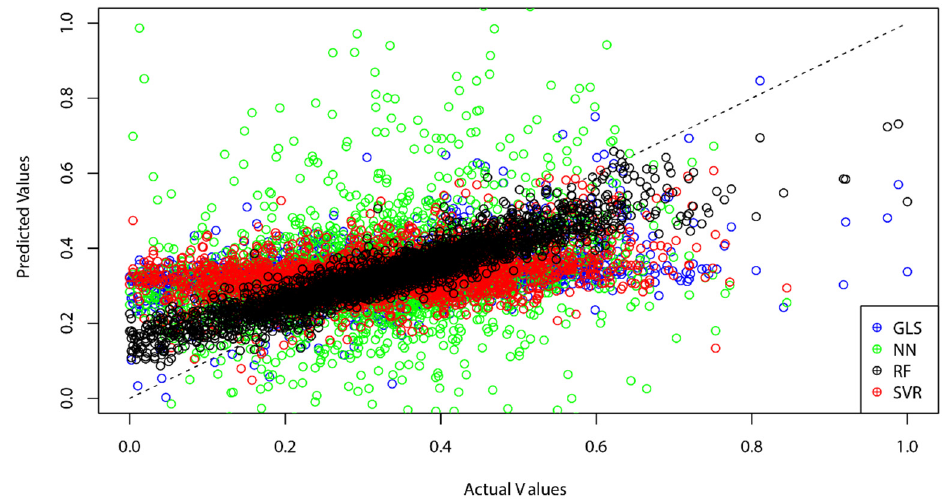
Figure 12. Scatter plot comparing the actual and predicted poverty headcount rates of 2015 (obtained from four machine-learning algorithms). Source: Calculation and graphics generated by authors.